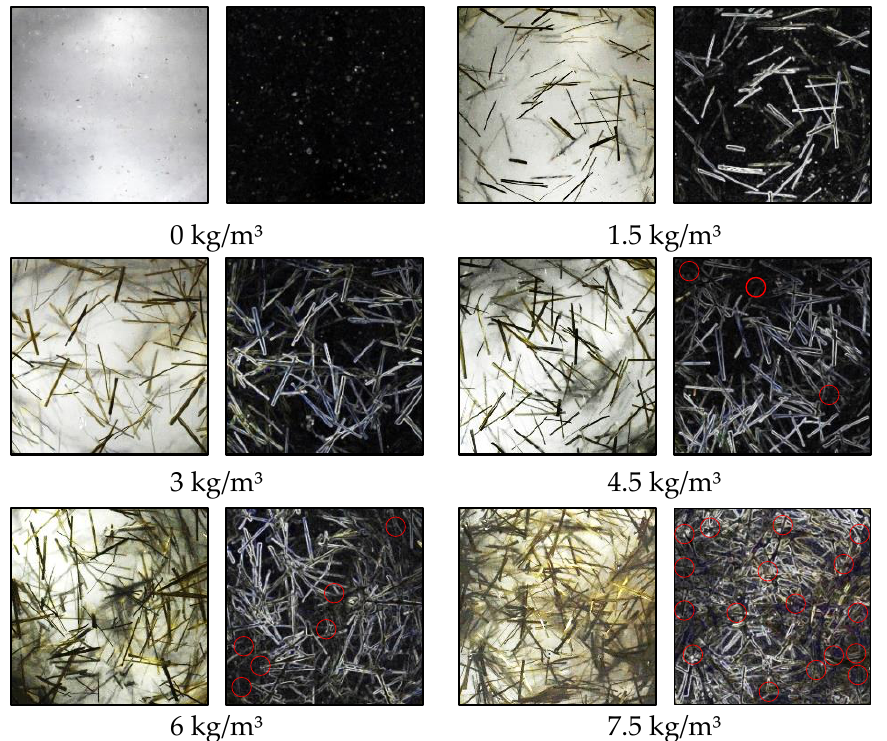
Figure 6. Binary images of the BF distribution pattern in transparent model with different BF dos- ages.